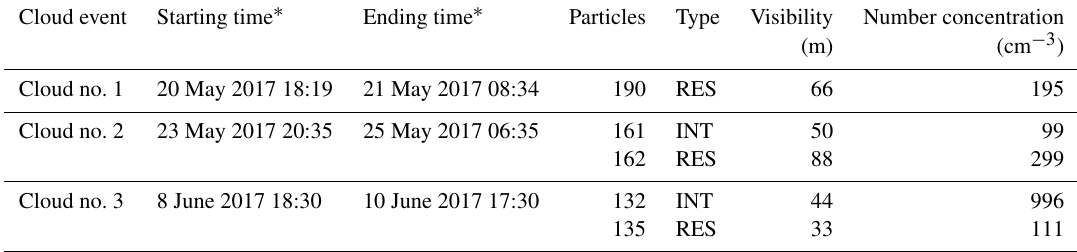
∗ Local time, i.e., Chinese standard time, UTC +